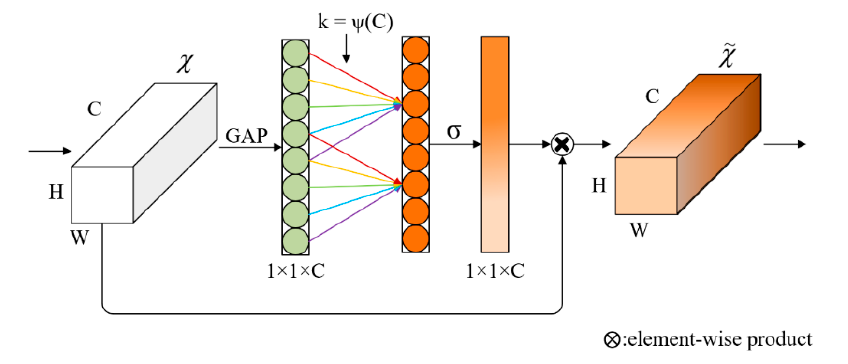
Figure 9. ECA-Net